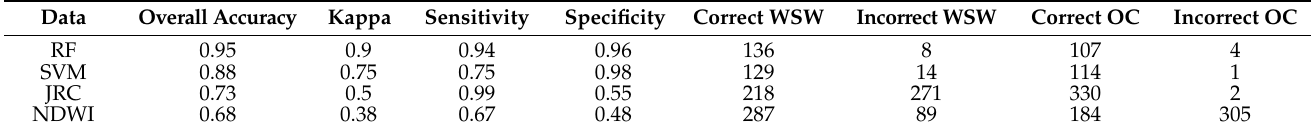
Table 4. Accuracy assessment of supervised classification of wetland surface water (WSW) vs. other classes (OC) for the year 2016 on the test data subset that was withheld from model calibration.